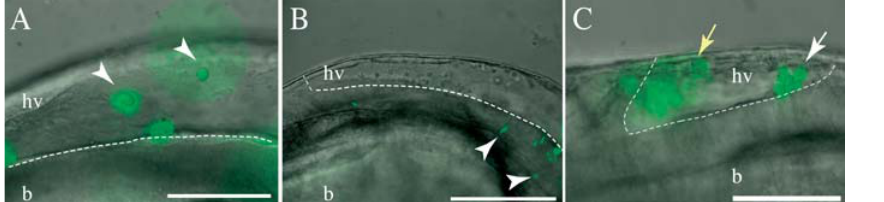
Figure 5. Normal Macrophage Chemotaxis to Initial Sites of D RD1 Infection Overlay of DIC and fluorescent images showing the hindbrain ventricle (hv) of infected embryos. The hindbrain ven- tricle/brain (hv/b) boundary indicated by a white dashed line. (A) D RD1-infected embryo 4 h post- infection with individual infected mac- rophages marked by arrowheads. (B) D RD1-infected embryo 5 h postin-